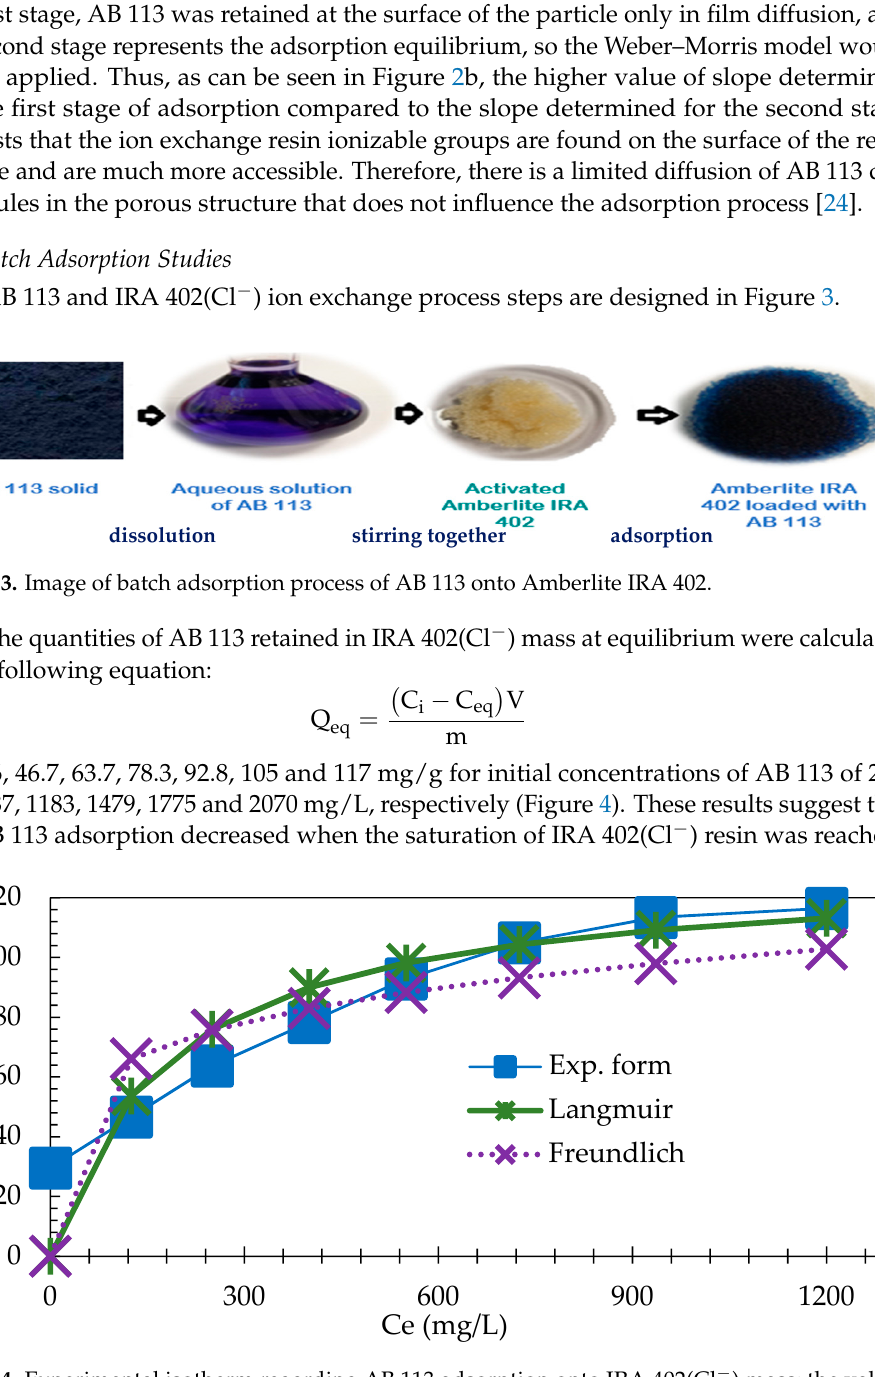
Figure 4. Experimental isotherm regarding AB 113 adsorption onto IRA 402(Cl − ) mass; the values presented are the averages of three replicates with RSD% below 8% for all experiments.